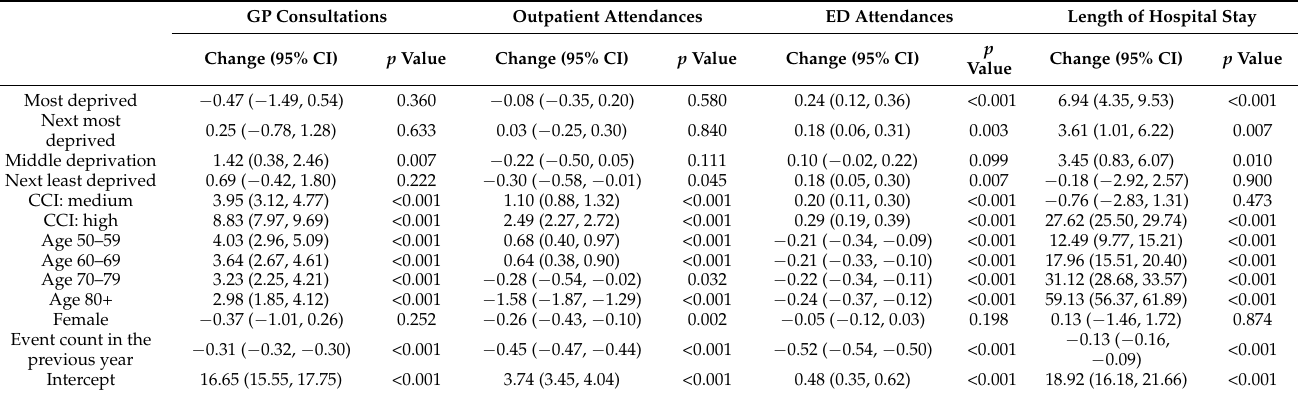
Table 3. Factors associated with the difference between 1-year pre-critical-care HRU and 1-year post-critical-care